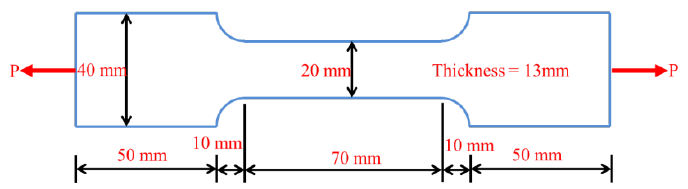
Figure 1. Shape and size of uniaxial tensile specimen.